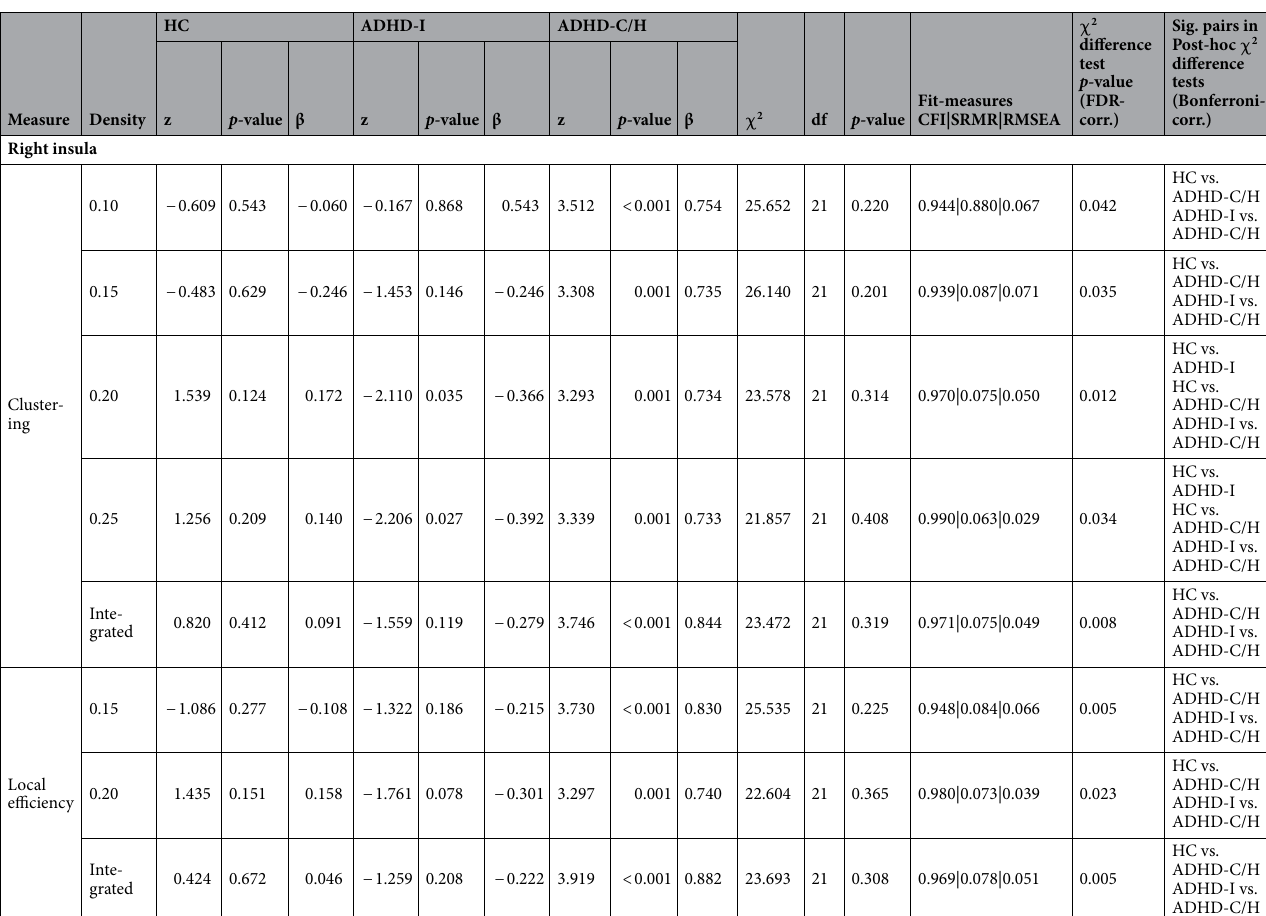
Table 2. Results of multi-group structural equation model analysis. Significant results after FDR-correction are given for the SEM with local efficiency, clustering coefficient of the right insula. All but the last column refer to the three-group SEM with group-specific regression parameter estimates. Group-specific z-statistics for the relation between the latent emotion dysregulation variable and the topology measures, parameter-specific p -values (uncorrected), which were obtained by using the quotient of the estimates and their standard error as a test statistic, and β estimates of the completely standardized solution are displayed for significant density- integrated models and the corresponding density-specific models (as calculated with χ 2 -difference tests). The table also displays model-specific χ 2 , degrees of freedom, p -values of the models, goodness-of-fit measures (CFI, SRMR, and RMSEA), p -values that are the result of χ 2 difference tests between the main models and the corresponding models with fixed regression parameters, and significant pairs of the post-hoc two-group SEM. Significant two-group differences mainly exist between the ADHD-C/H group and the other two groups. ADHD-C/H: combined or predominantly impulsive/hyperactive attention-deficit/hyperactivity disorder; ADHD-I: predominately inattentive attention-deficit/hyperactivity disorder; HC: healthy